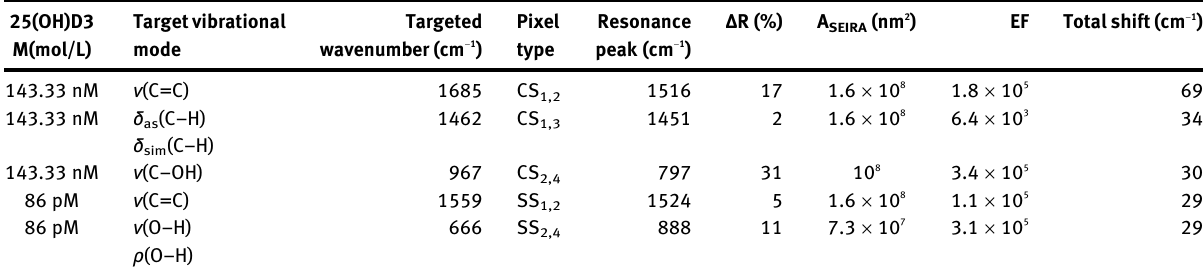
Table  : Summary of main measurement results.